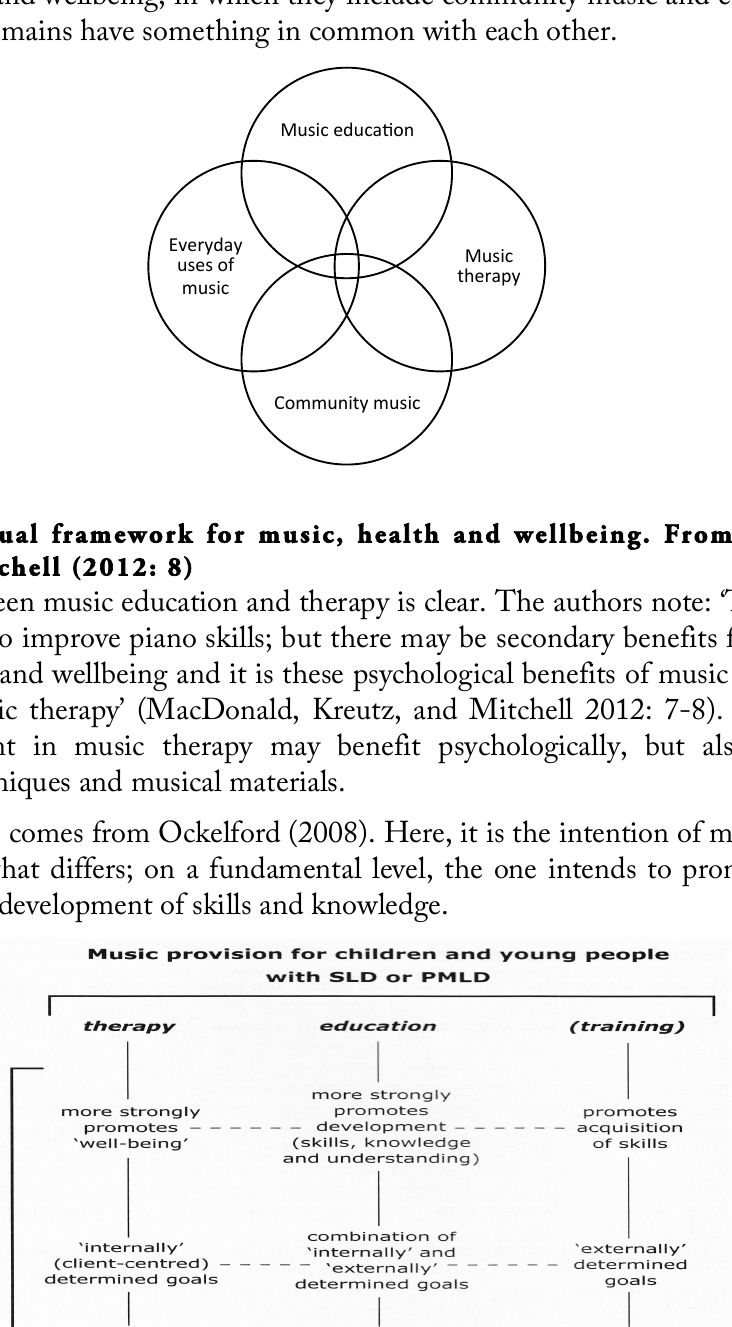
Fig.2.2 The extent to which